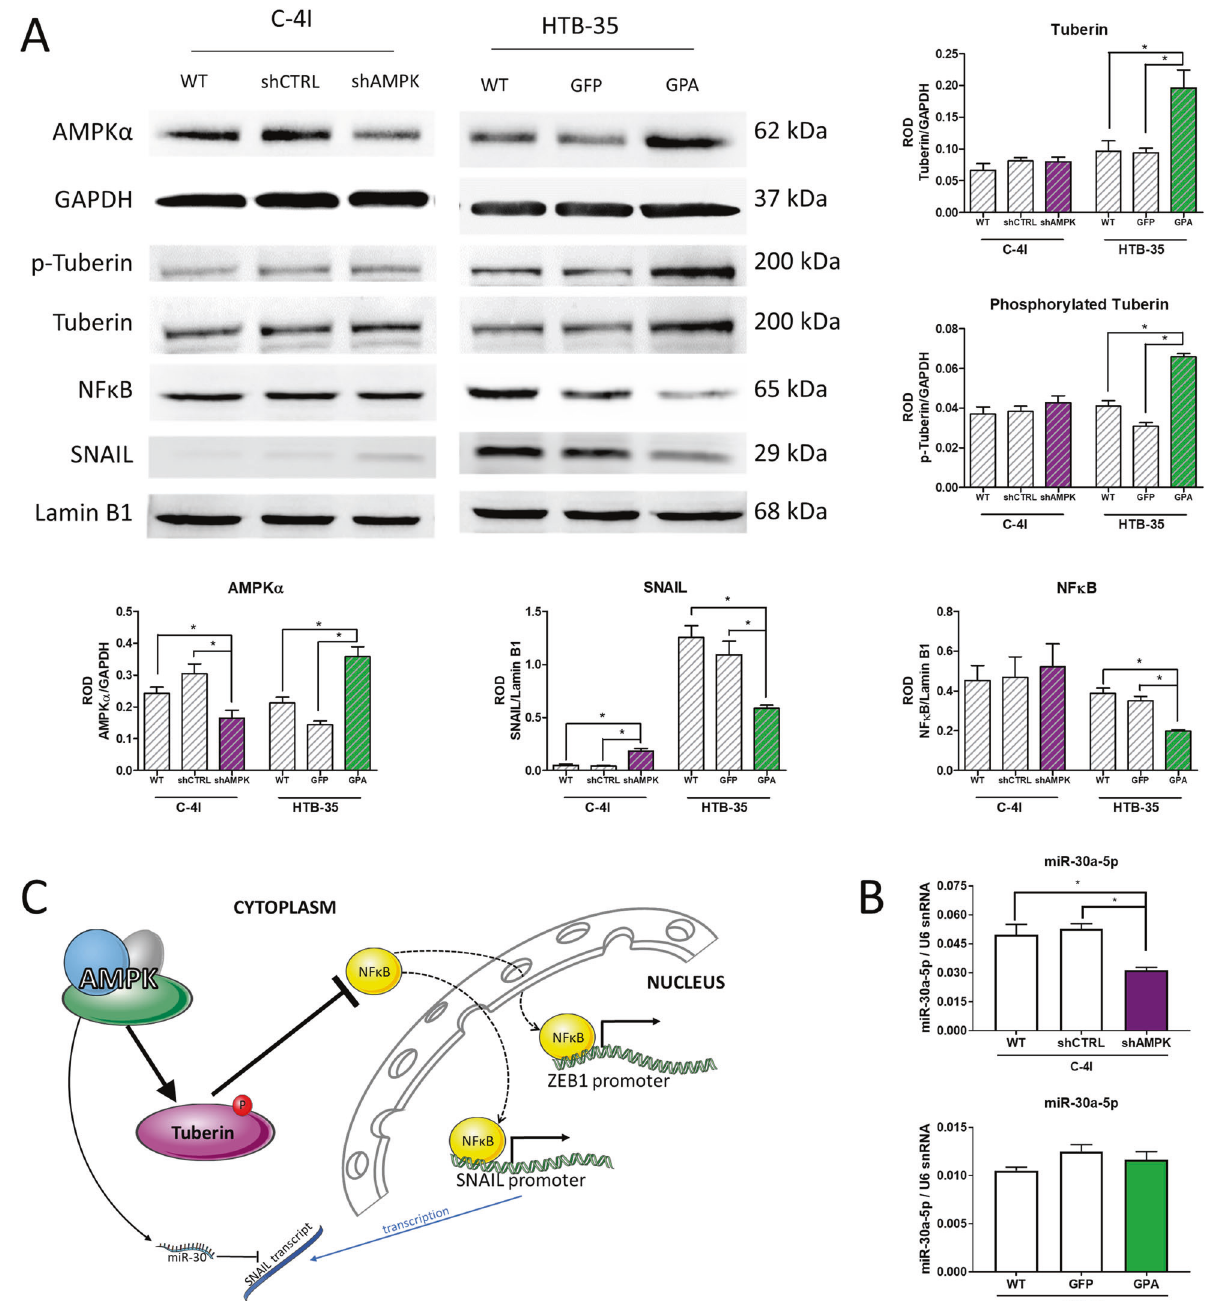
Fig. 5 Modi fi cation of AMPK α 1 expression in the CC cells moderates the expression of Snail and ZEB-1 via tuberin-NF κ B pathway. A Changes in tuberin expression and activation, NF κ B, and SNAIL expresion as a result of AMPK α expression modi fi cation; B evaluation of expression levels of miR-30a-5p in C-4I and HTB-35 modi fi ed cells. C Scheme of AMPK regulation of SNAIL and ZEB1 expression; Membrane pictures show representative results of three independent experiments. The graphs represent the mean of three independent evaluations of the relative expression of the analyzed gene to the reference gene ± SEM. Asterisks indicate statistically signi fi cant differences ( p <